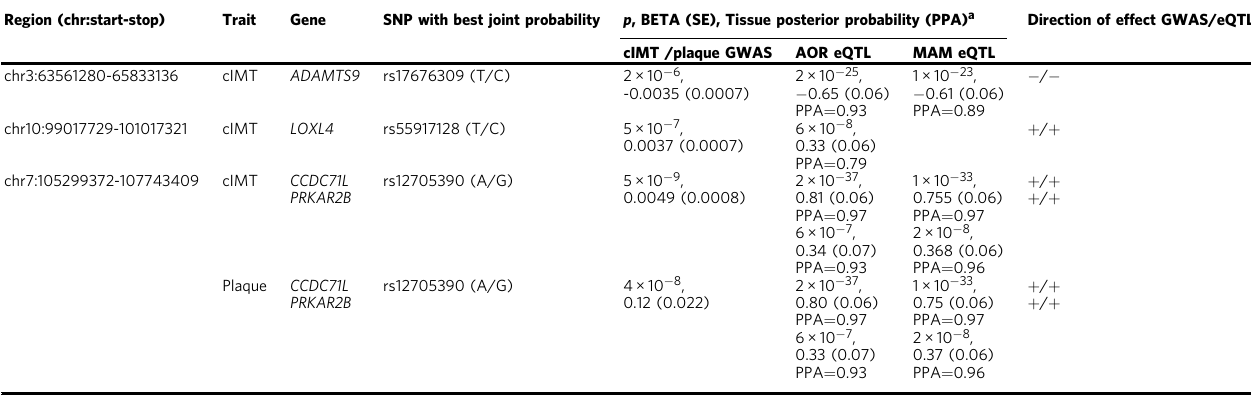
Table 3 Colocalization of cIMT and plaque with eQTLs in tissues from patients with CHD in STARNET tissues for genes/tissues combinations that have more than 75% probability to share the same associated variant Region (chr:start-stop) Trait Gene SNP with best joint probability p , BETA (SE), Tissue posterior probability (PPA) a Direction of effect